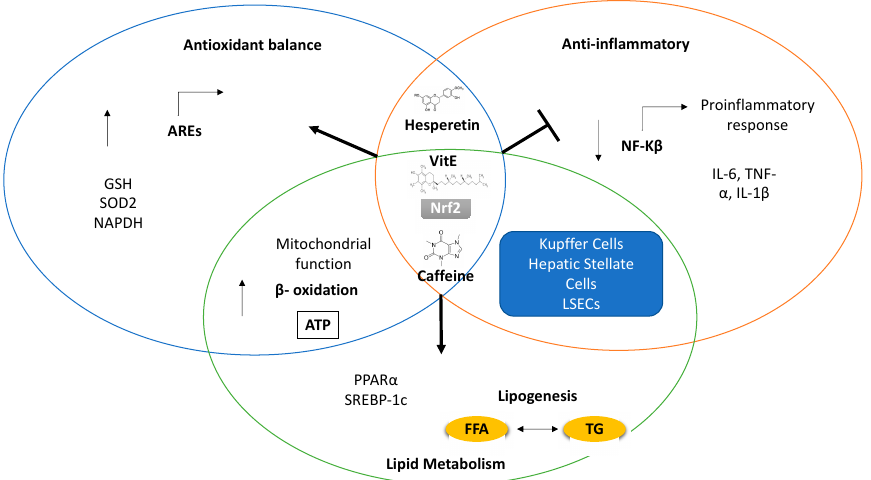
Figure 2. Potential therapeutic strategies for NAFLD based on antioxidant potential. Main mechanisms related to the poten- tial therapeutic effect of antioxidant agents in NAFLD, according to experimental evidence. During NAFLD progression, ROS overproduction leads to an impairment of the antioxidant balance and lipid metabolism and to a proinflammatory response, resulting in liver injury. Therapeutic antioxidant effects are mediated by the activation of Antioxidant Response Elements (AREs) regulated by the Nrf2 and NF-kB pathways. Restoration of mitochondrial function normalizes lipid metabolism by restoring the balance between lipolysis and triglyceride synthesis and improves β -oxidation and ATP generation. Finally, anti-inflammatory effects, mainly via inhibition of NF- κ B-dependent transcription, prevent liver injury and non-alcoholic steatohepatitis (NASH)